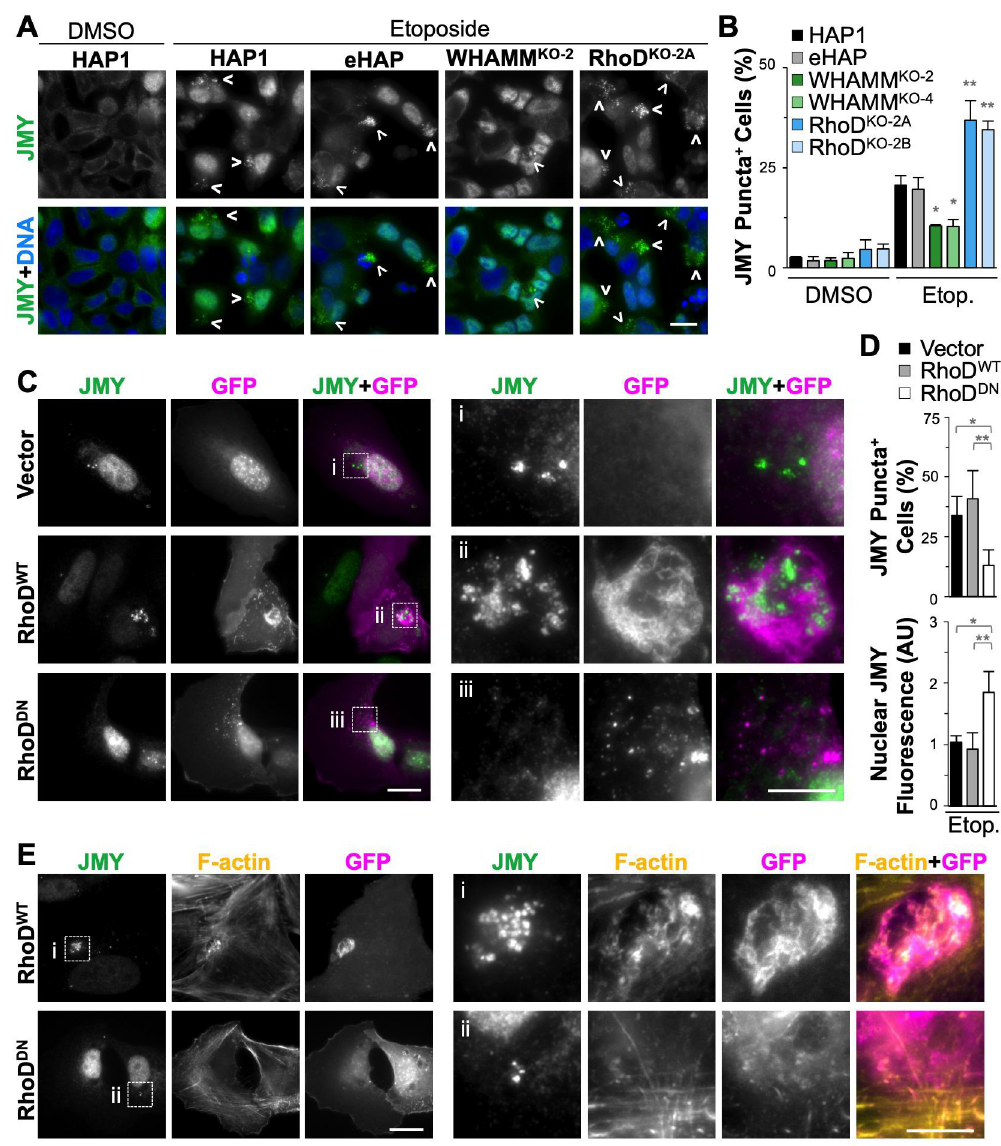
Fig 10. WHAMM and RhoD affect the organization of cytoplasmic territories containing JMY, cytochrome c , and F- actin. (A) HAP1, eHAP, WHAMM KO , and RhoD KO cells were treated with DMSO or 5 μ M etoposide for 6h before being fixed and stained with a JMY antibody (green) and DAPI (DNA; blue). Arrowheads highlight examples of cytosolic JMY puncta. Scale bar, 25 μ m. (B) The % of cells with JMY puncta was calculated using ImageJ. Each bar represents the mean % ± SD from 2 experiments (n = 170–346 cells per bar). Significance stars refer to comparisons to parental cell lines. (C) U2OS cells transfected with plasmids encoding GFP (vector) or GFP-RhoD constructs (RhoD WT and RhoD DN ) were treated with 10 μ M etoposide for 6h before fixing and staining with a JMY antibody (green). GFP is shown in magenta. Scale bars, 25 μ m, 10 μ m. Magnifications (i-iii) represent examples of JMY localization. (D) The % of U2OS cells with JMY puncta was calculated in ImageJ and each bar represents the mean % ± SD from 3–4 experiments (n = 107–201 cells per bar). U2OS cells treated as in (C) were also stained with DAPI. Nuclear JMY fluorescence intensities were measured in ImageJ relative to those of the vector sample. Each bar represents the mean ± SD from 3 experiments (n = 105–186 cells per bar). AU = Arbitrary Units. (E) U2OS cells treated as in (C) were stained with phalloidin to label F-actin (yellow). Magnifications (i,ii) represent examples of GFP-RhoD localizations. Scale bars, 25 μ m, 10 μ m. � p < 0.05, �� p < 0.01 (ANOVA, Tukey post-hoc tests).